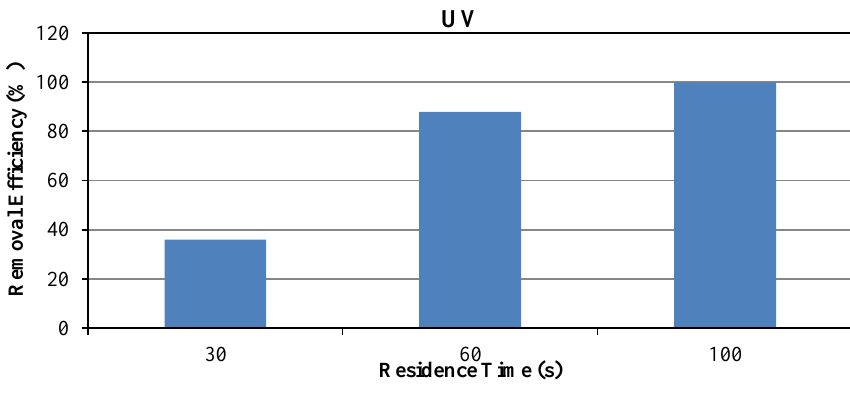
Figure 4. Removal efficiency at different residence